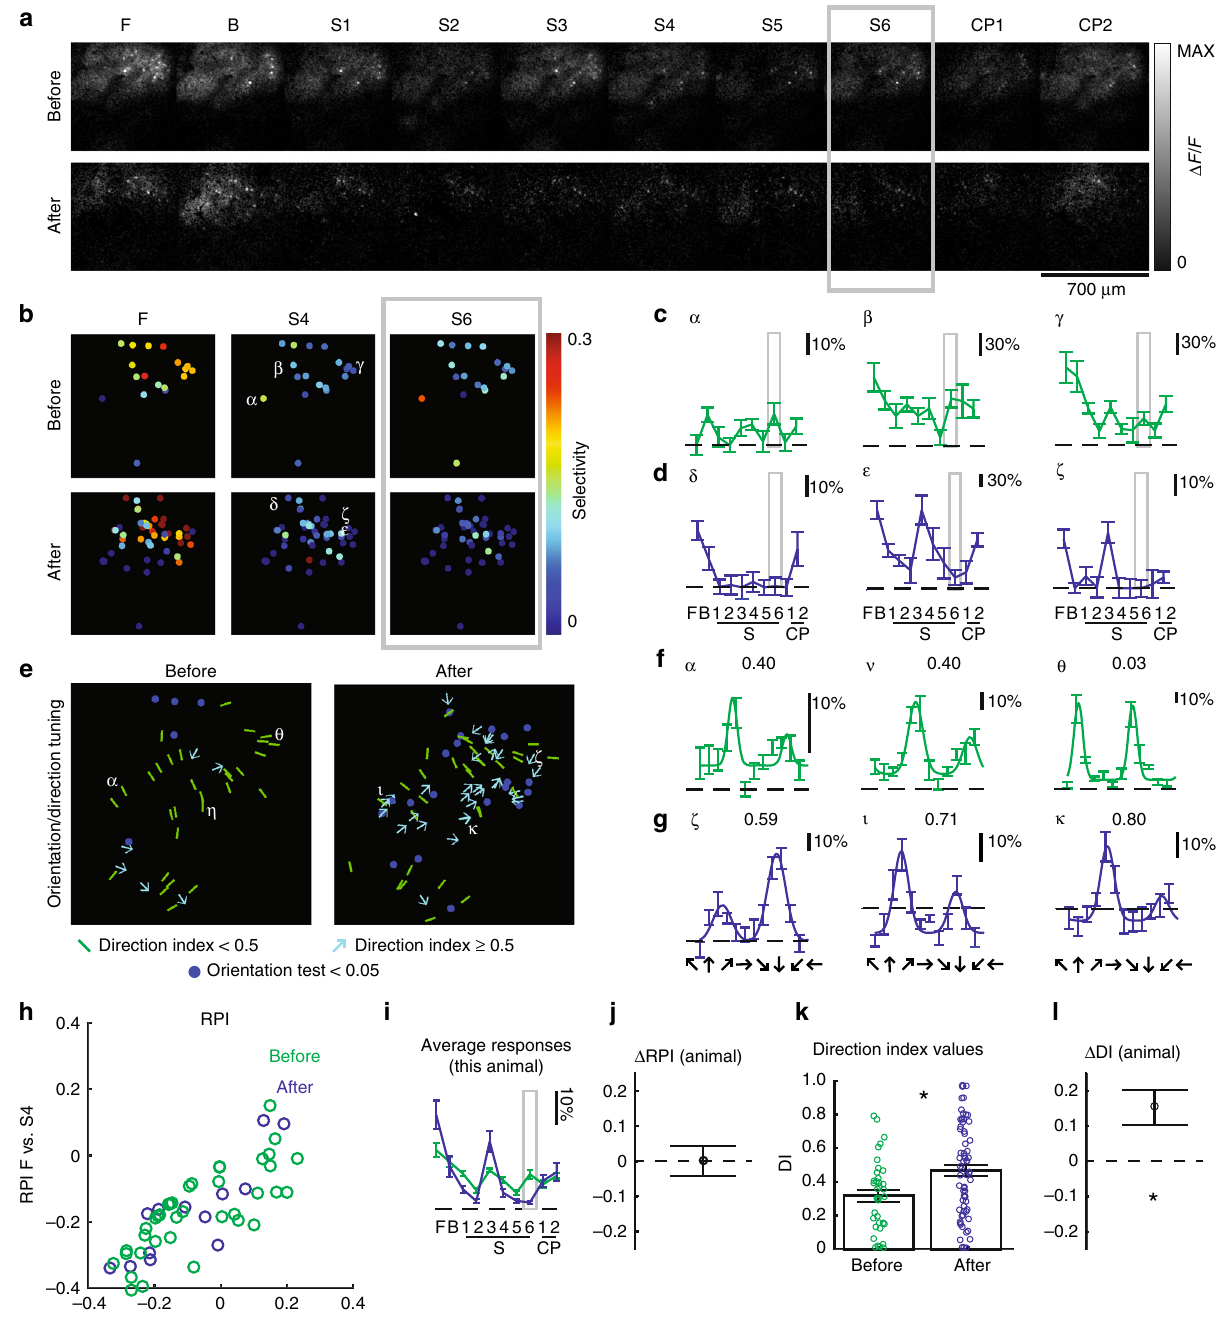
Fig. 5 In a ferret with 5 days of visual experience, 6 h of experience with a phase-scrambled grating pattern caused an increase in direction selectivity rather than selectivity for the phase-scrambled pattern. The eyes opened naturally on day P33, and the experiment was performed at P38. Panels a – l are as described in Figs. 2 – 4. S6 was used as the training stimulus. In this animal, some cells were tracked across some trials and Greek letters appear more than once. N = 13 cells before and N = 41 cells after for measurements of F, B, S1 – 6, CP1 – 2, and N = 36 cells before and N = 67 cells after for direction tuning. This animal exhibited no change in selectivity to training stimulus S6, and exhibited a signi fi cant increase in direction